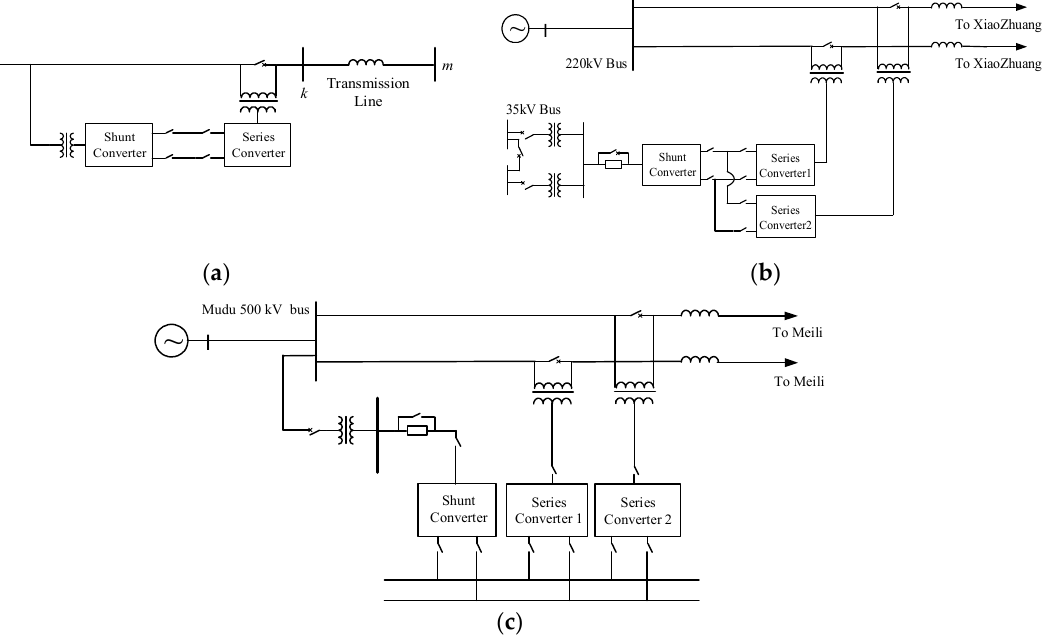
Figure 1. The structures of unified power flow controller (UPFC) projects: ( a ) Schematic diagram of the conventional structure UPFC; ( b ) Schematic diagram of the UPFC project in Nanjing western grid; ( c ) Schematic diagram of the UPFC project in Suzhou southern grid.